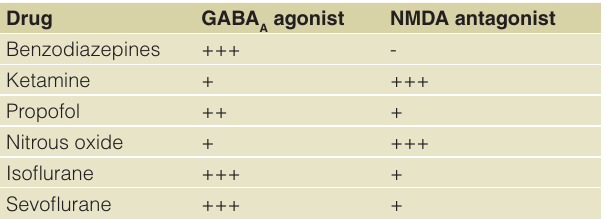
Table 3. Putative mechanism of sedatives and general anaesthetics on gamma-aminobutyric acid (GABA and N-methyl d -aspartate (NMDA)